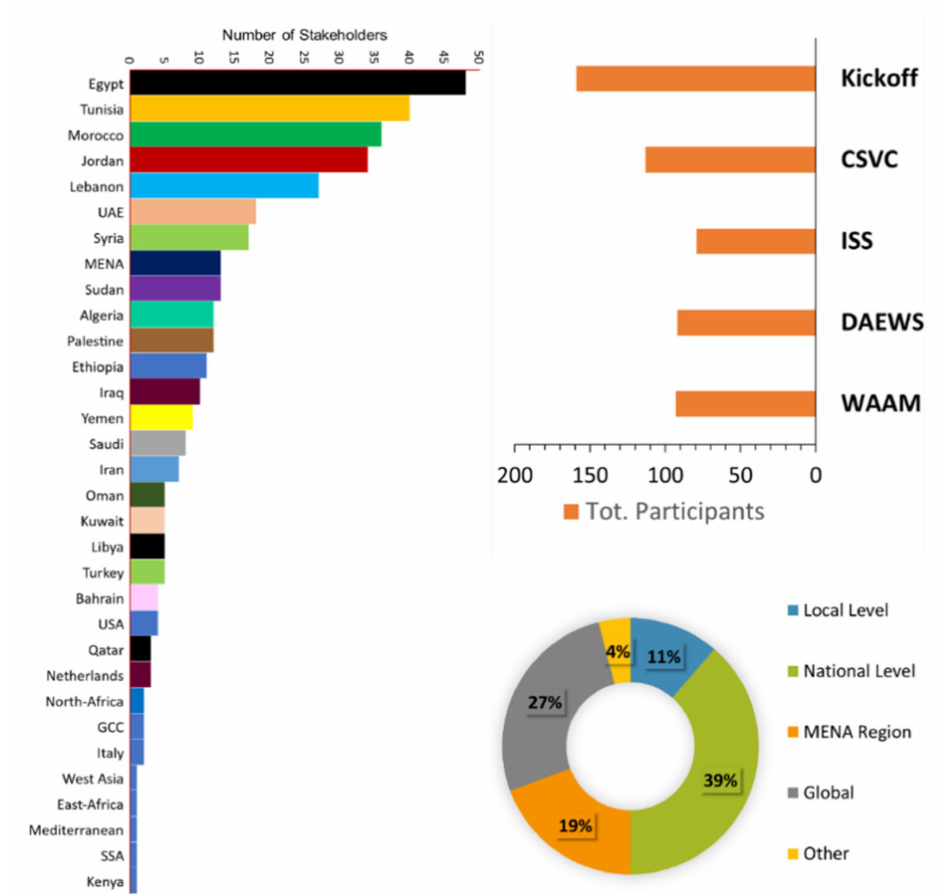
Figure 4. Analysis of stakeholder participants who attended the MENA-GC stakeholder consultation webinar series. The first figure shows countries represented and the second figure right panel shows the number of participants who participated in each webinar. The pie chart represents the geographical scale of interest of the